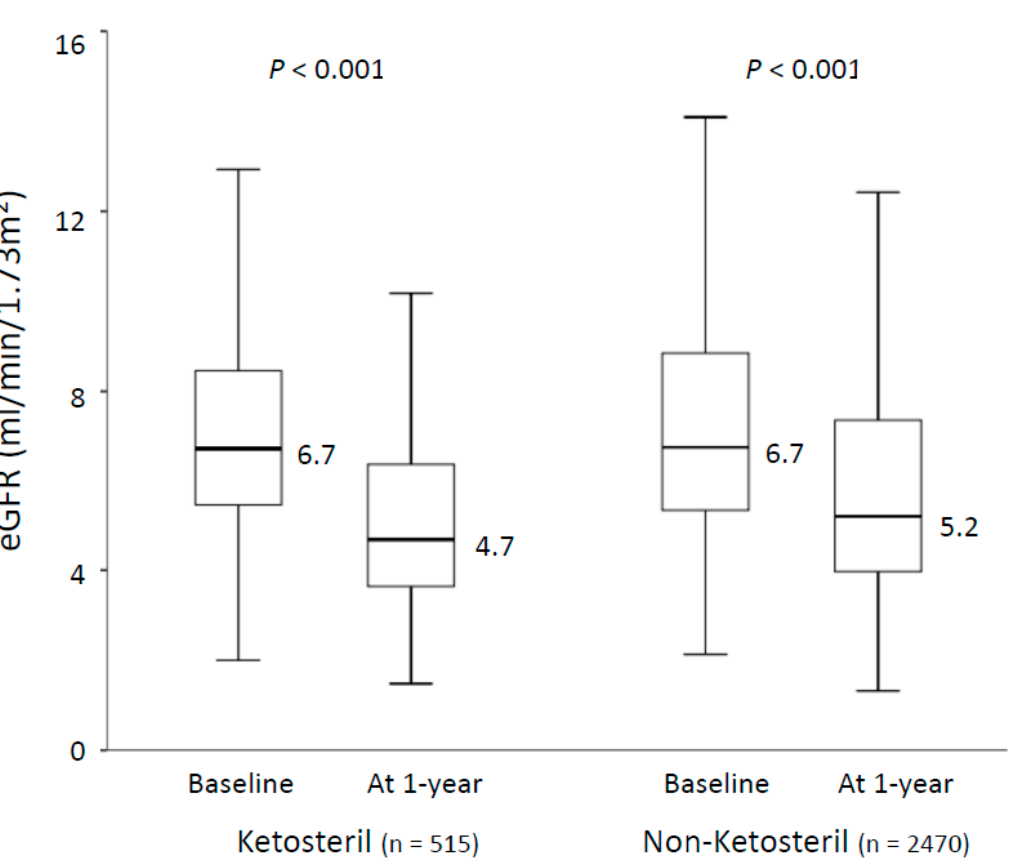
Figure 2. Mean eGFR change from baseline to 1 year follow-up of patients in the Ketosteril and non-Ketosteril groups. The lower whisker is the first quartile minus 1.5 times the interquartile range and the upper whisker is the third quartile plus the 1.5 times interquartile range. TheeGFRsignificantlydeclinedinbothstudygroups(Ketosterilgroup: from6.7to4.7mL / min / 1.73m 2